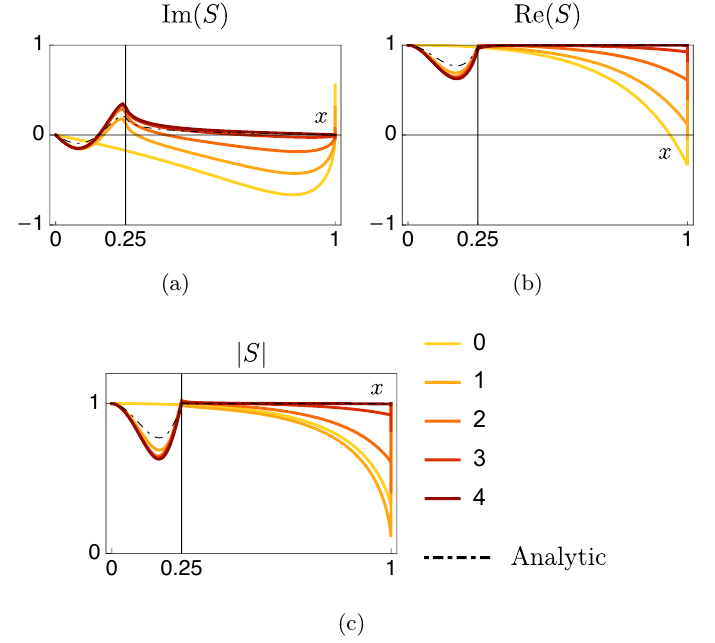
Figure 1 . Results of the algorithm with no bound state and an arbitrary but regular enough starting point (displayed). Convergence is exponentially fast, so we show only the first five iterations. The inelastic input chosen here is given in (3.12) with H = 120 . Linear interpolants, grid given in (A.1). a) Imaginary part of the S-matrix: iterations (color), analytic (dot-dashed). (b) Real part. (c) Modulus of the S-matrix. 7 seconds for 100 iterations and the grid of